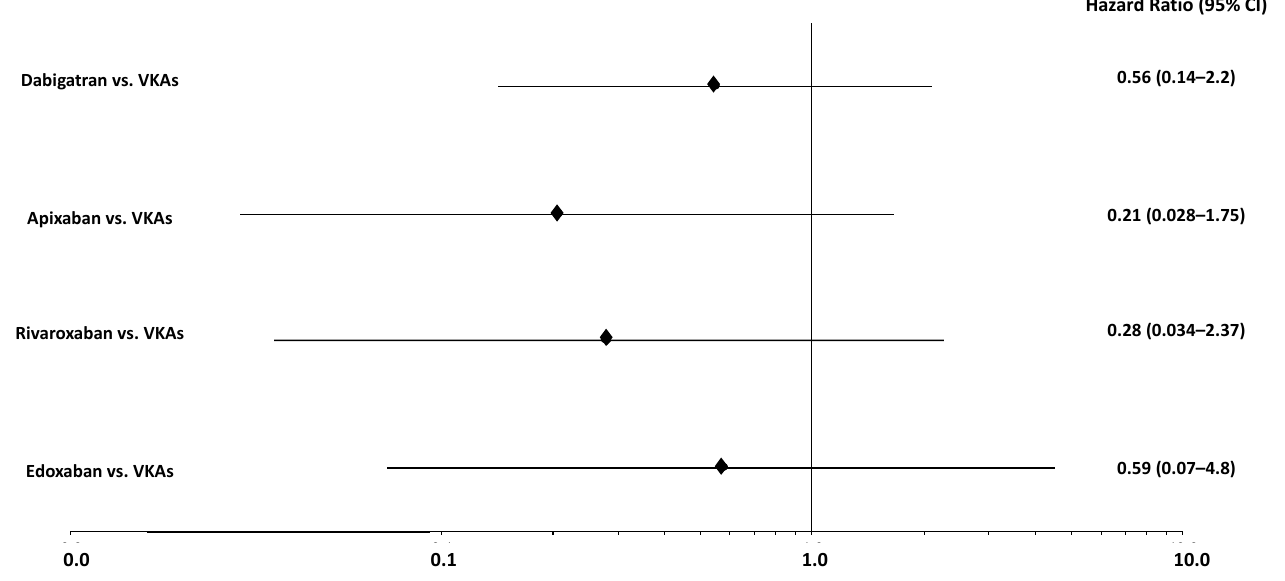
Figure 3. Hazard ratios for post-intervention pocket hematoma with different NOACs vs. VKAs. NOACs = Non-vitamin K antagonist anticoagulants; VKAs = Vitamin K antagonist Table 4. Study outcomes at 30-day follow-up